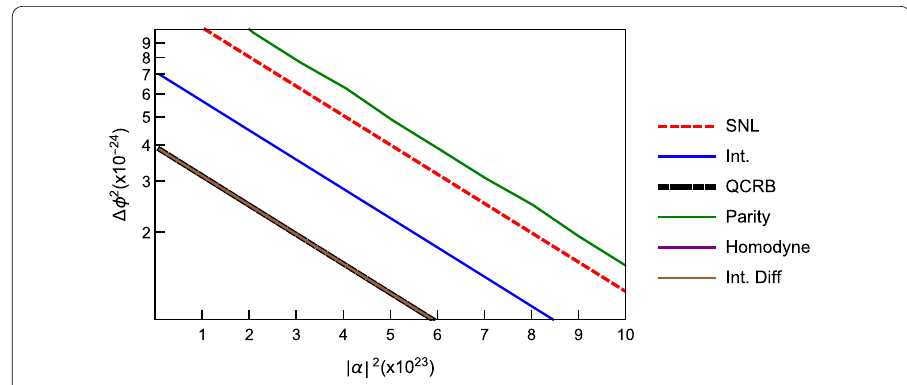
Figure 3 Log plot of phase variance for various detection schemes for a coherent state and squeezed vacuum into an MZI, as a function of the average coherent photon number, | α | 2 , shown in the very large power regime. Total loss parameters have been set to L = 20%. We have assumed one can set the control phase to its optimal value, to obtain the best phase variance in each measurement choice. Squeezing strength in the squeezed state is set to r = 1. Note that Parity is now not able to achieve even sub-SNL, due to loss, while homodyne and intensity difference quickly approach the QCRB (appear on top of one another). SNL and QCRB are also plotted with the same lossy